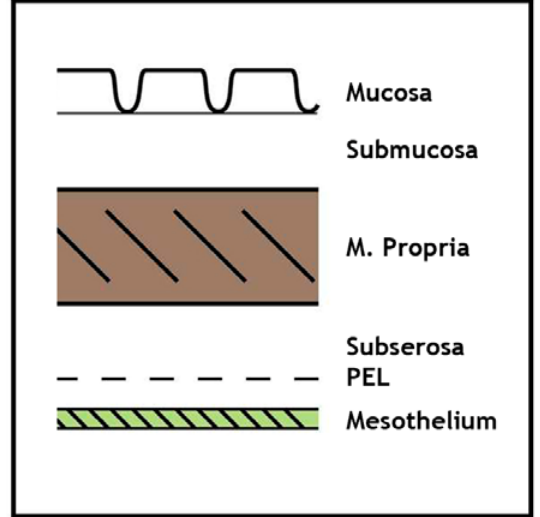
Figure 1. Schematic outline of the colorectal wall. M. propria: muscularis propria. PEL: peritoneal elastic lamina.